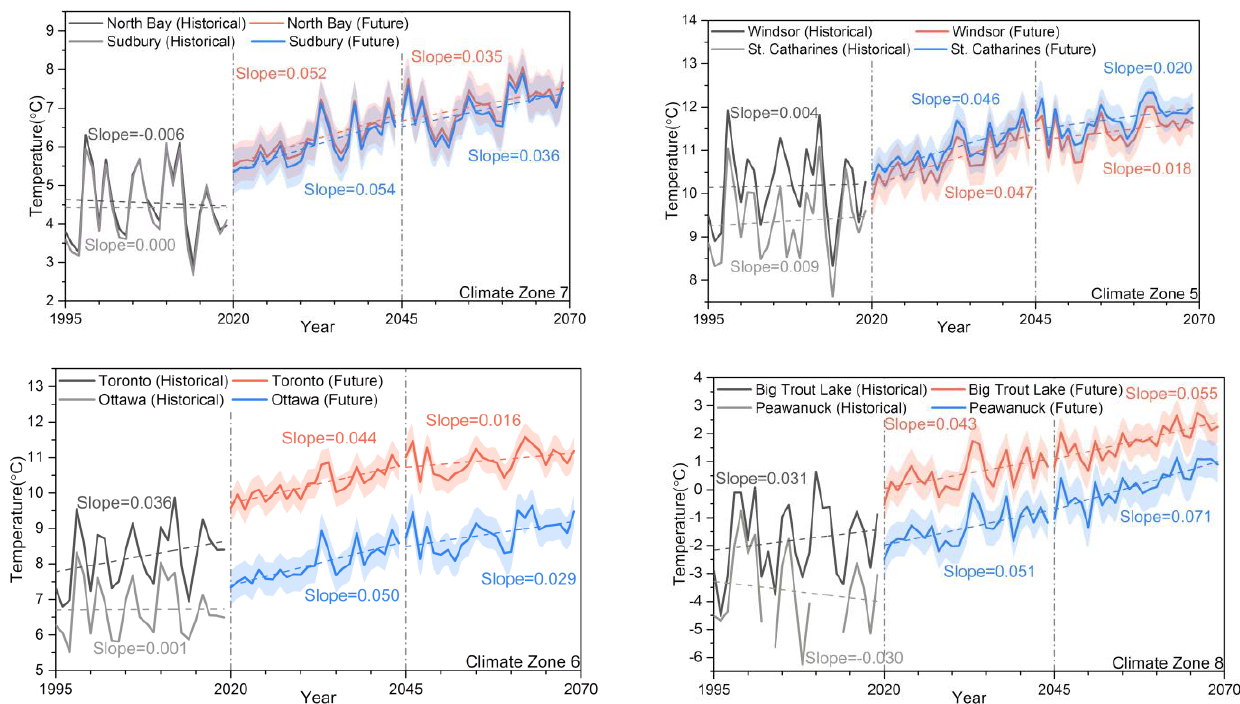
The annual average temperature was calculated based on daily temperature data from the past 25 years to the future 50 years. For the forecasted values, the average was further averaged using the results from the 5 models. The calculation results were plotted in Figure 4 to analyze the variation tendency of annual temperature for the 8 cities for individual climate zones. As shown, the gray and black curves on the graph represent the annual temperature of two cities in one climate zone for the past 25 years, whereas the colored curves stand for the prospective annual temperature values. Moreover, the dash lines in the diagram are the rates of change concerning each fluctuant curve, which is forecasted within each independent period. The values of the slopes are indicated beside the corresponding curve.